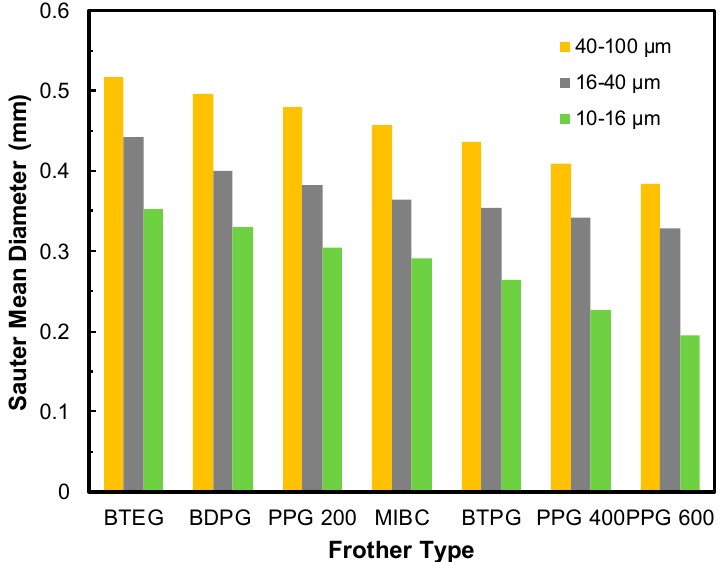
Figure 5 . Effect of frit pore size on SMD of bubbles. Figure 5. Effect of frit pore size on SMD of